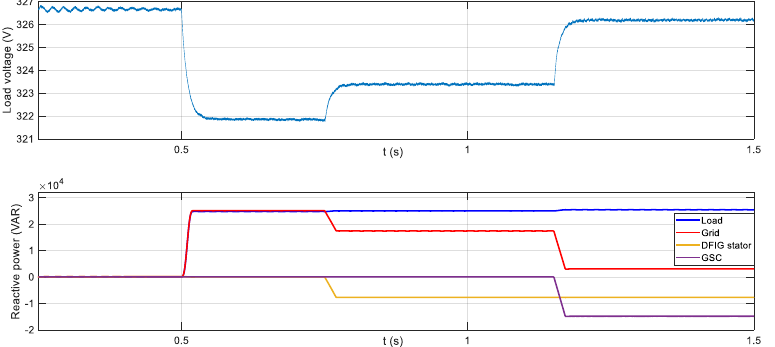
Figure 15. Load voltage for inductive load and voltage compensation with the controlled DFIG reactive power for Figure 14 structure.